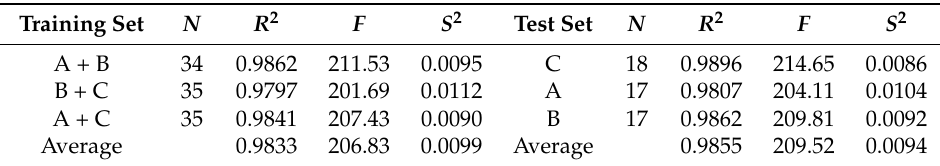
Table 5. Internal validation of the QSAR model a